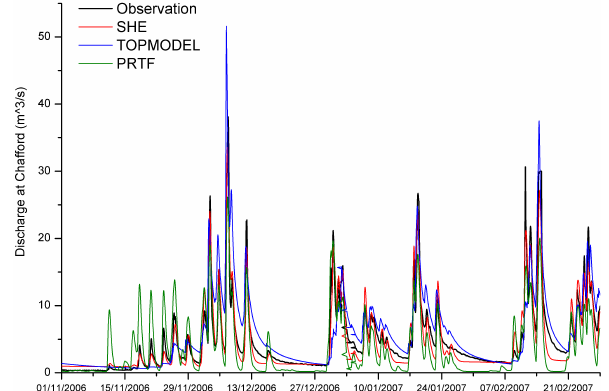
Fig. 2. Model calibration performance among MIKE SHE, TOP- MODEL and PRTF. Fig. 3. Model validation performance among MIKE SHE, TOP- MODEL and